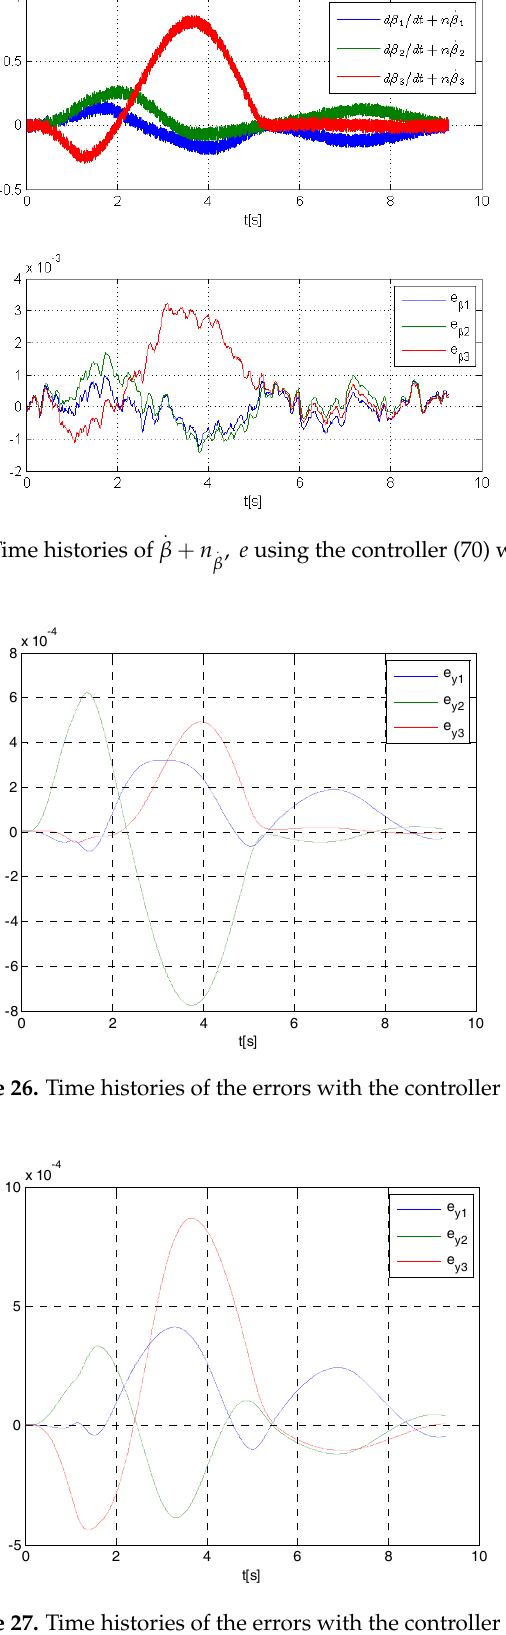
Figure 27. Time histories of the errors with the controller (72).